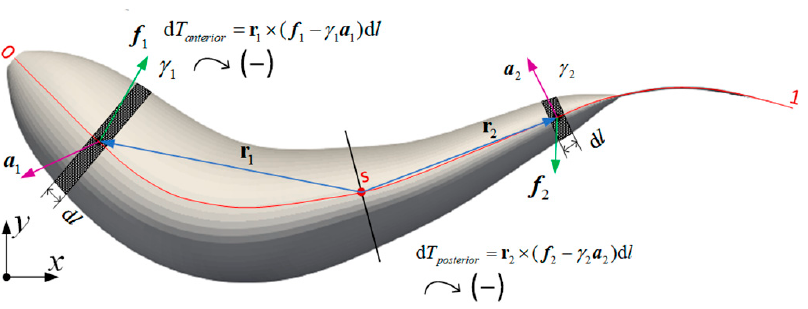
Figure 4. Diagram of internal torque. The black shaded area represents the element along the body axis.